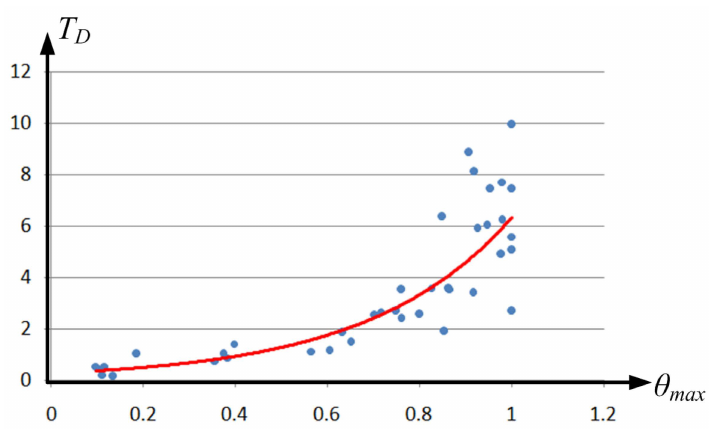
Figure 5. Regression curve and points for T D vs. θ max for the data in Table 1.